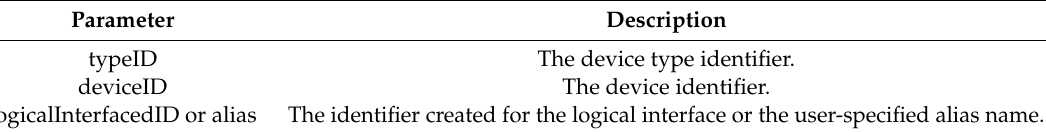
Table 6. Request identifier parameter.